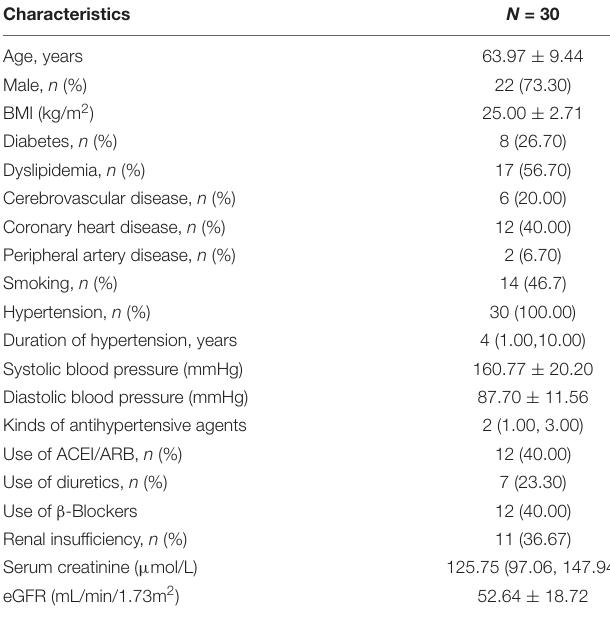
TABLE 1 | Patient characteristics ( n =